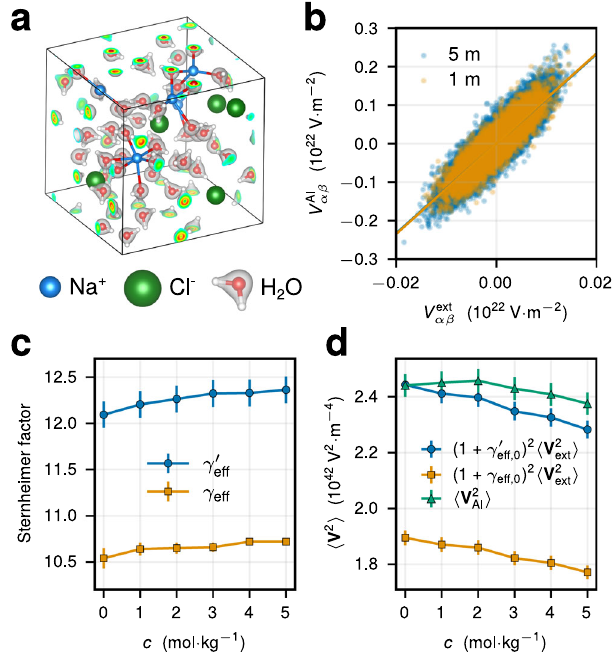
Fig. 1 | Electron cloud contribution to the EFG at the Na + position. a Representative system con fi guration of a NaCl solution at 5m. The gray opaque regions around water molecules show charge densities obtained with DFT PAW calculations (see Methods). b Component-wise comparison of ab initio EFGs, V AI αβ , against classical EFGs, V ext αβ , at the position of Na + ions on the same set of con fi g- urations for different salt concentrations c . The solid lines indicate the fi t for an effective Sternheimer factor γ eff : V AI αβ = ð 1+ γ eff Þ V ext αβ . c Effective Sternheimerfactors for Na + obtained from the linear fi t (yellow squares) or from the ratio Þ 2 = h V 2 i = h V 2 i (blue circles) at different c . d EFG variance at the Na + posi- ð 1+ γ 0 AI ext eff tion fordifferent c asobtained directlywithabinitio calculations (green triangles), or using the value of γ eff (yellow squares) and γ 0 eff (blue circles) at in fi nite dilution. The error bars in c , d were calculated using